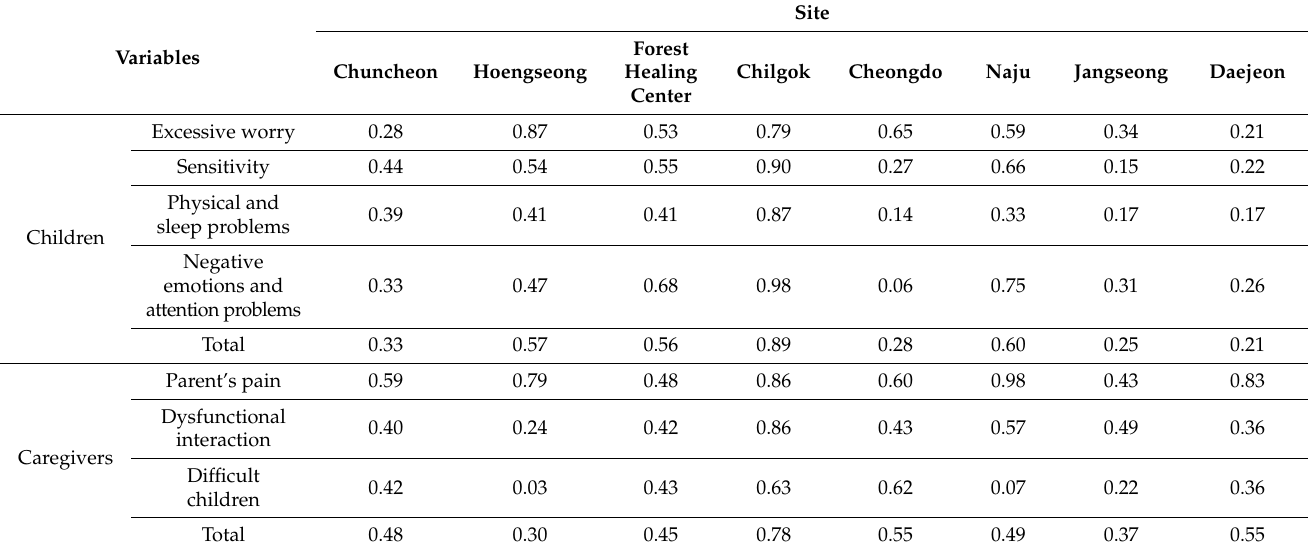
Table 9. A Comparison of the Effects of Forest Healing Program on the